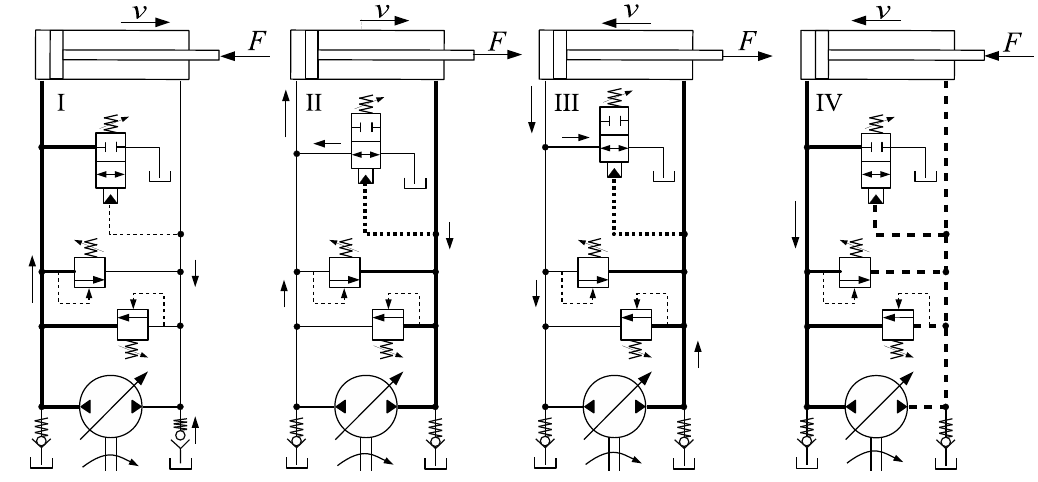
Figure 3. Four quadrant operation of Frankenfield’s circuit.